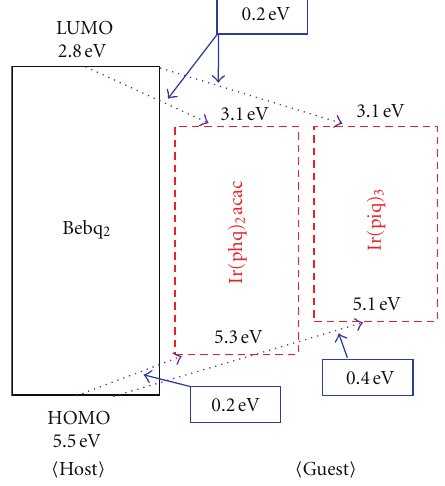
Figure 10: Energy level diagram of the Bebq 2 fluorescent host and Ir(phq) 2 acac and Ir(piq) 3 red phosphorescent dopant